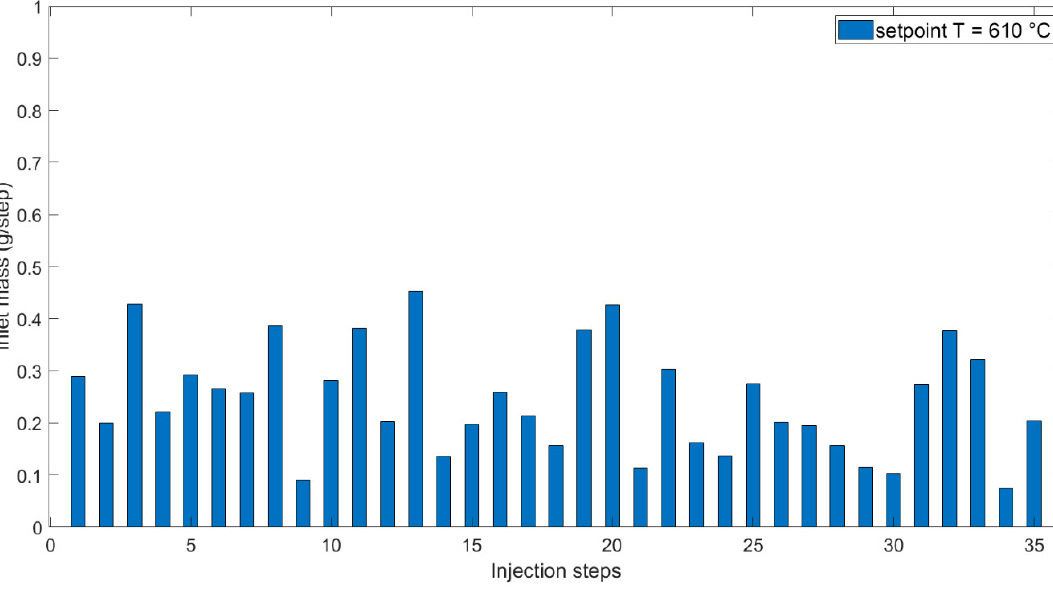
◦ C setpoint Figure 10. Inlet mass against injection steps at 610 °C setpoint temperature. Figure 10. Inlet mass against injection steps at 610 Figure 10. Inlet mass against injection steps at 610 °C setpoint temperature.